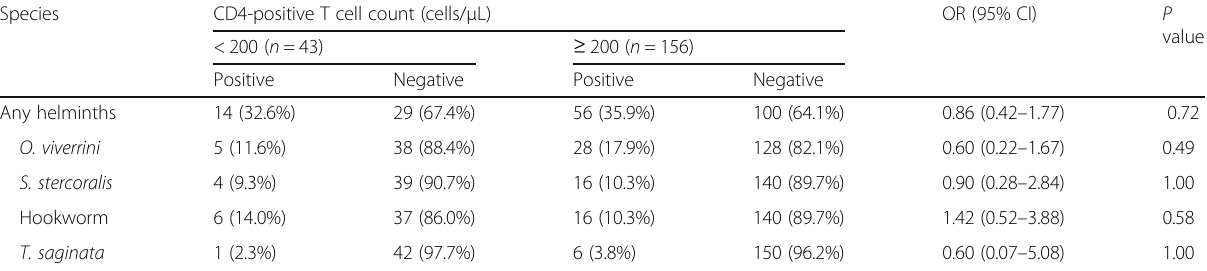
Table 4 Association of intestinal helminths with the CD4-positive T cell count in HIV-infected patients ( n = 199; among the participants who were screened for helminths via stool samples, only 199 had available CD4-positive T cell count data)